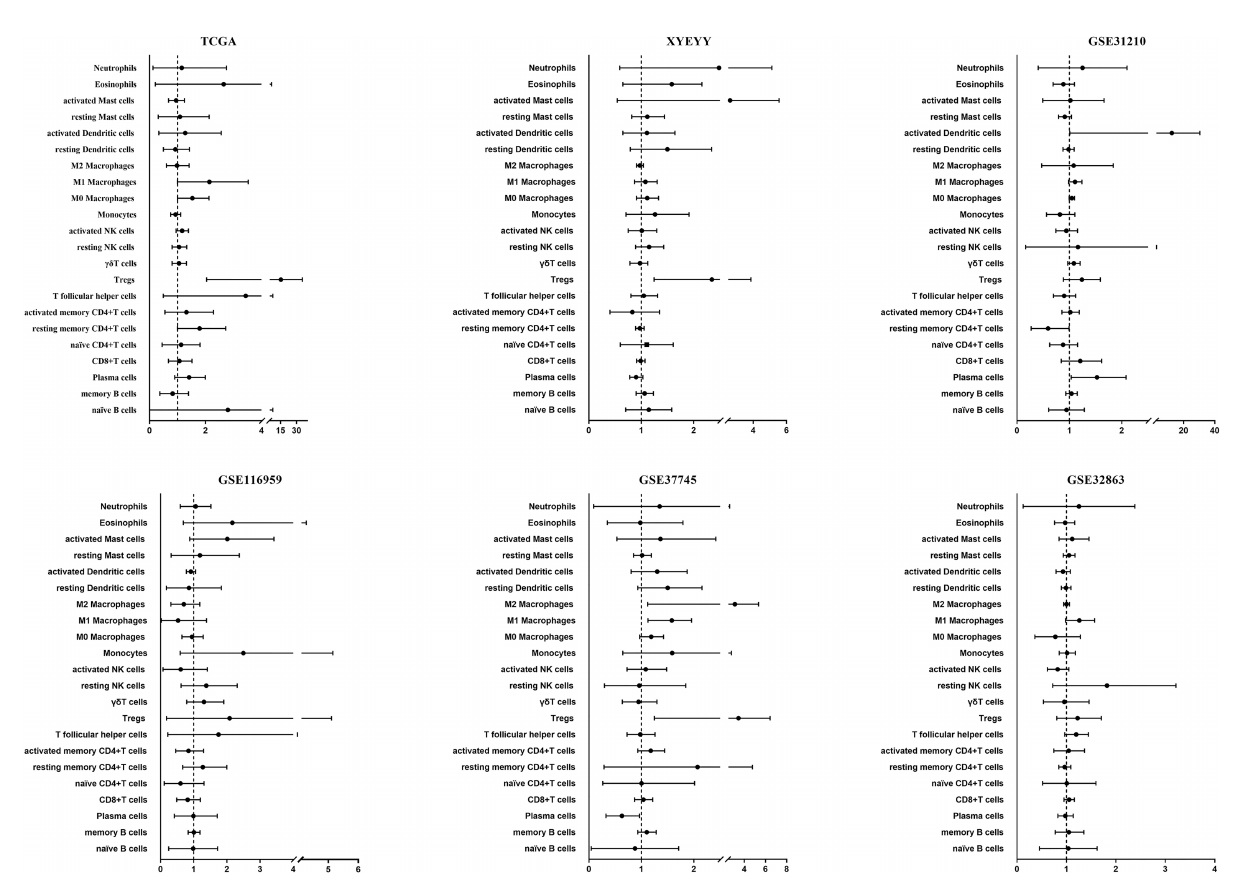
FIGURE 2 | Performance of TILs as a predictor for lung cancer early recurrence. In the TCGA cohort, multivariate analysis revealed that the in fi ltration of Tregs was signi fi cantly related to tumor early recurrence (HR: 8.49, 95%CI: 2.04-35.44, p = 0.003). A strong correlation between Tregs in fi ltration and tumor early recurrence was also found in the XYEYY cohort (HR: 1.93, 95%CI: 1.25-3.86, p < 0.01) and GSE37745 dataset (HR: 2.68, 95%CI: 1.25-6.44, p < 0.01). The in fi ltration of Tregs lost its signi fi cance in GSE31210, GSE32863, and GSE116959